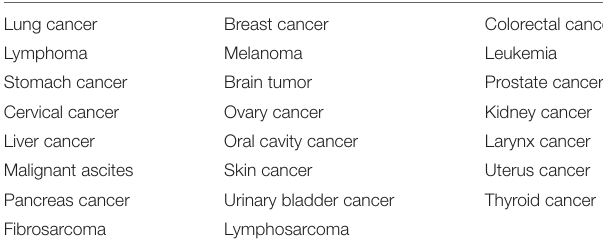
TABLE 1 | Some epidemiological forms of